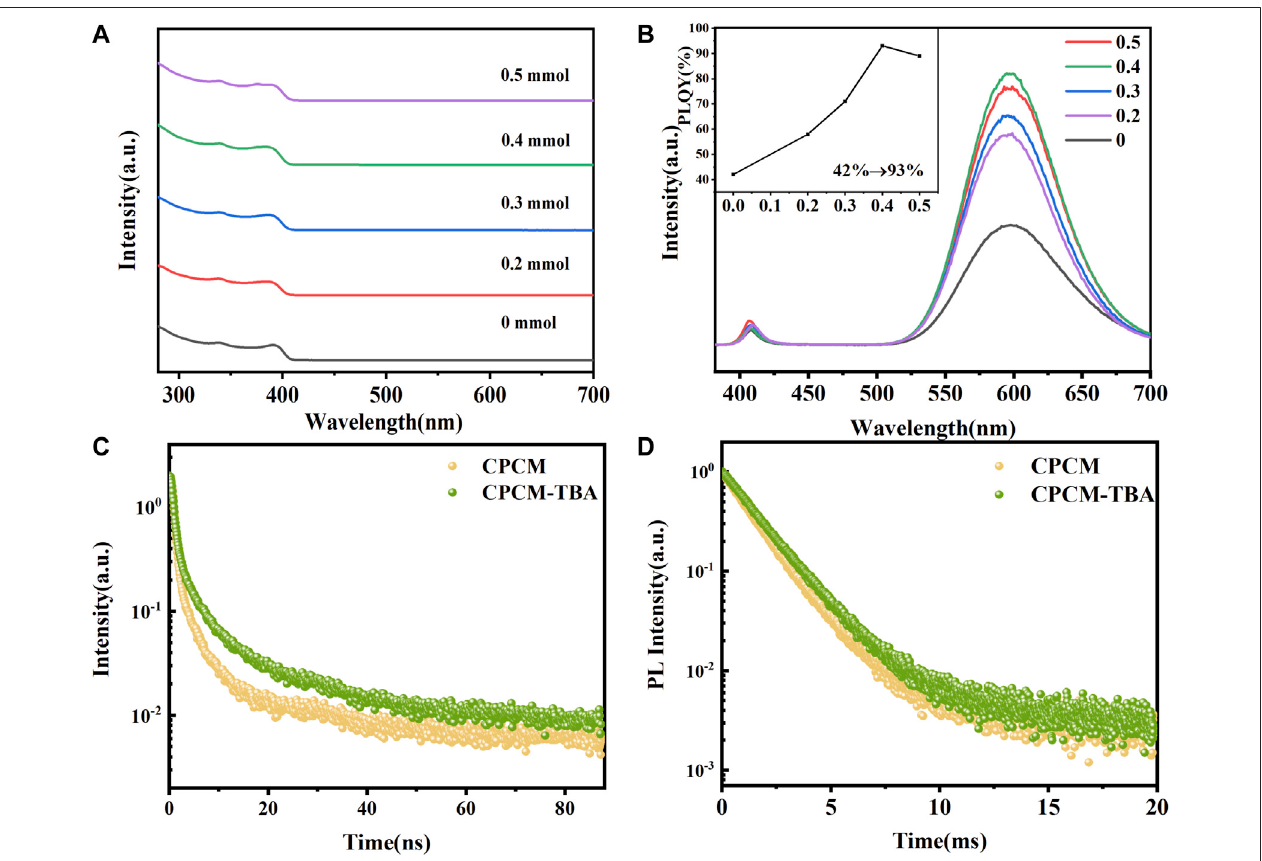
FIGURE 2 | Absorption (A) and emission spectra (B) of CPCM NCs with 0 – 0.5 mmol of TBA; time-resolved PL decay of (C) exciton and (D) Mn 2+ emission of the CPCM-TBA NCs.